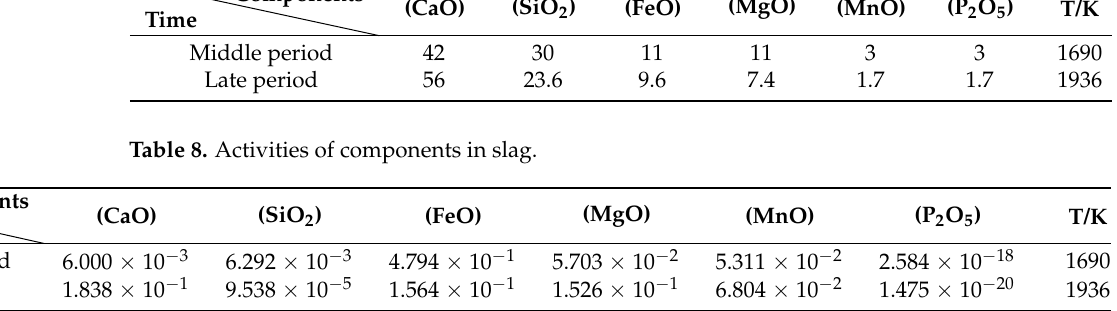
Table 5. The interaction coefficient of activity, e j